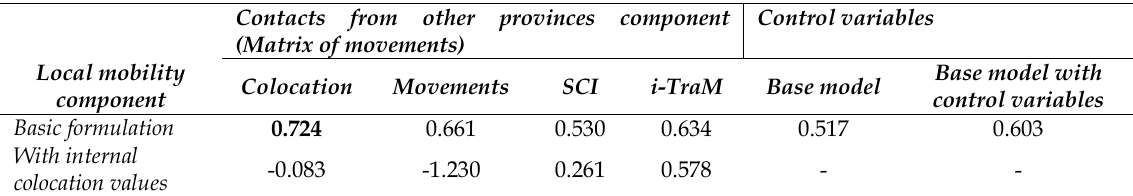
The comparison of pseudo R2 of the equations, according to three variants: the formulations for component 1 and 2 and the presence of control variables. Weeks 11- 41 (one week